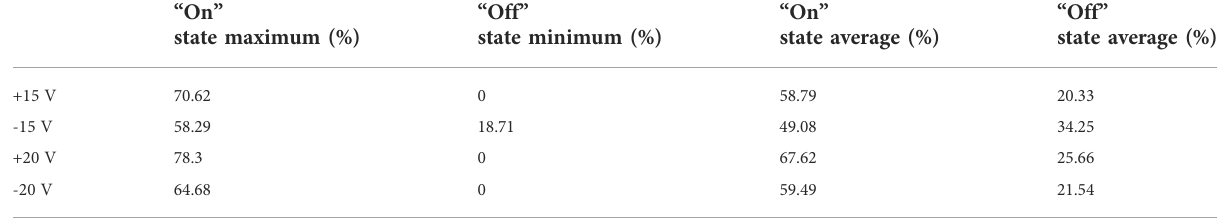
TABLE 1 The aperture ratio of different voltages in different states.